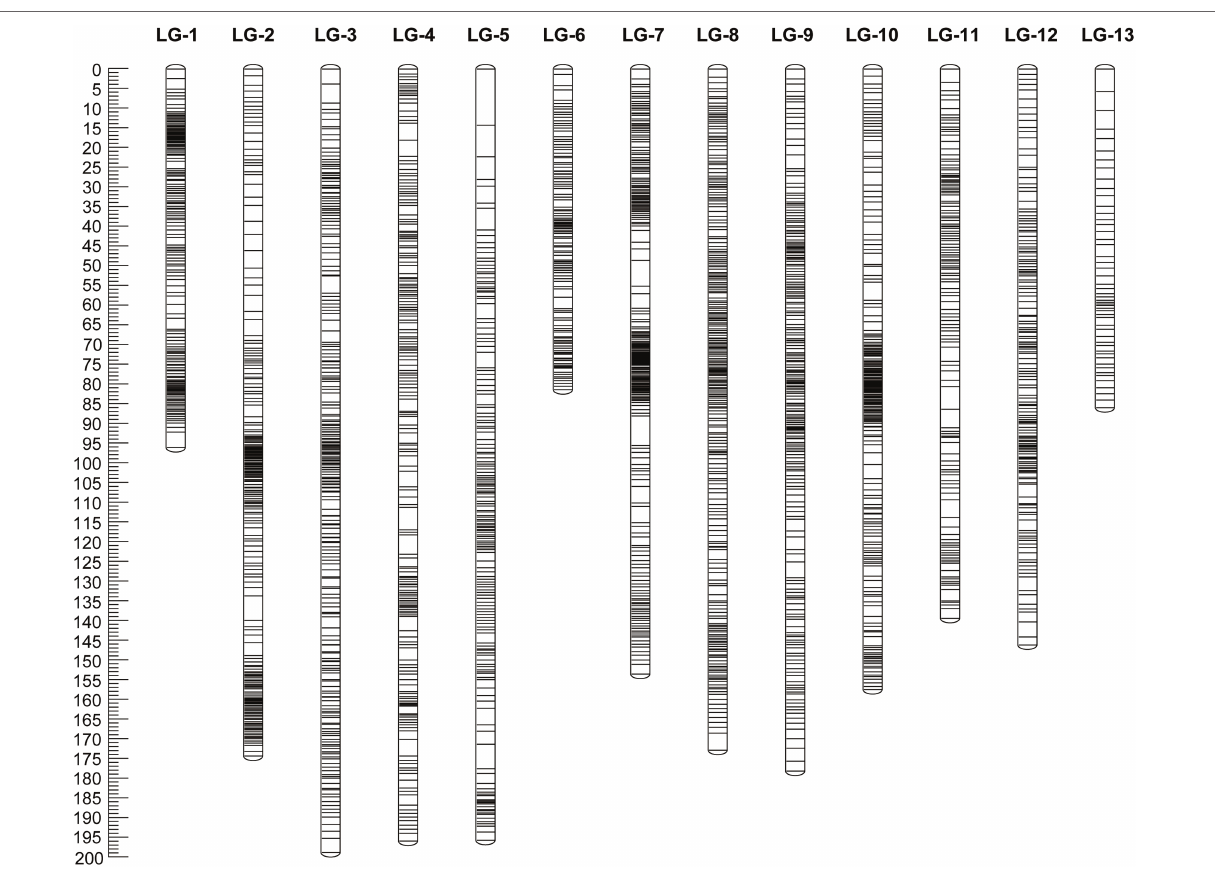
TABLE 1 | Characterization of the genetic linkage map of ‘Namikata 73’. Linkage group